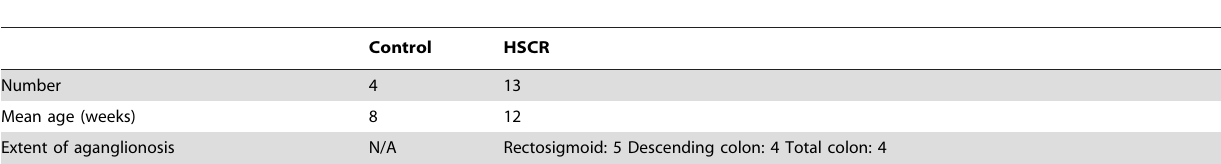
Table 1. Clinical parameters of human HSCR samples.